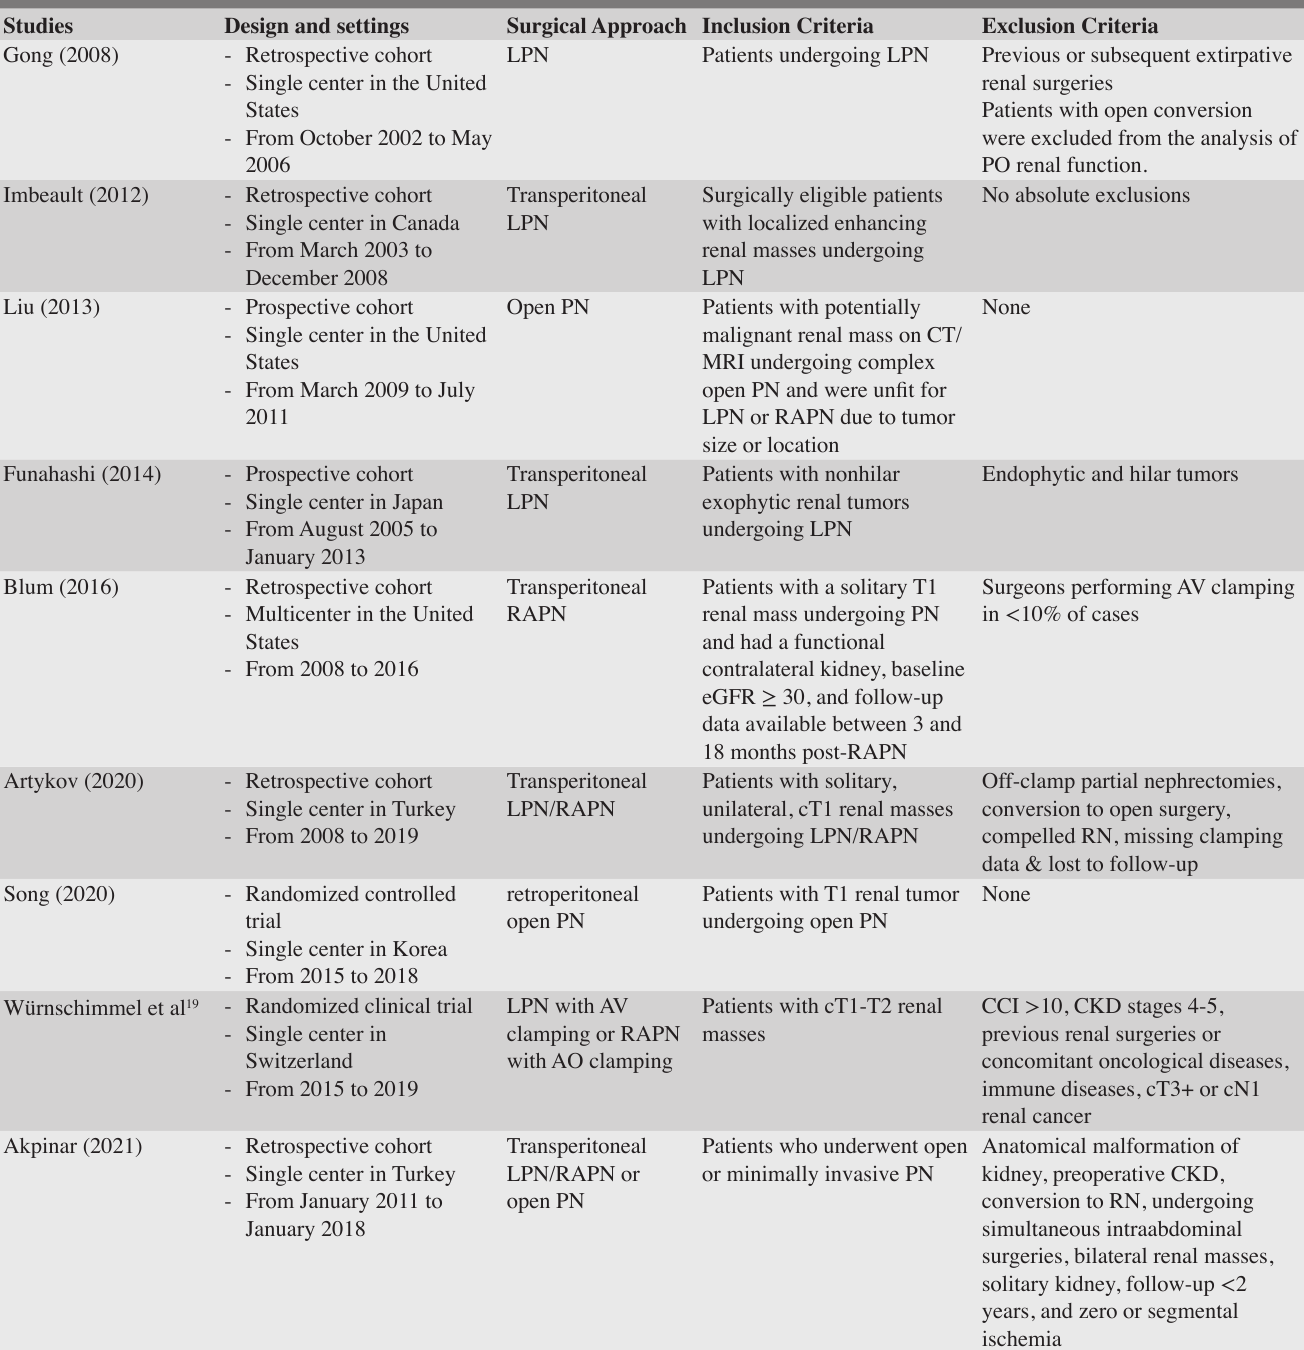
Table 1. The Settings and Eligibility Criteria of the Included studies (n = 9)